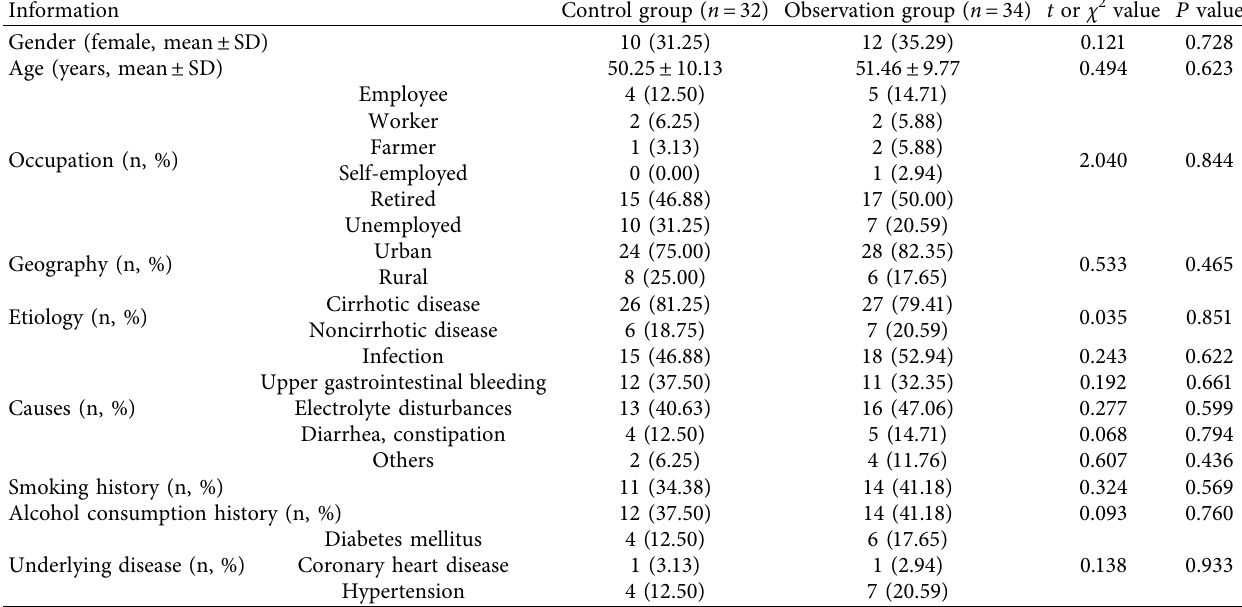
Table 1: Comparison of general data of the two groups.